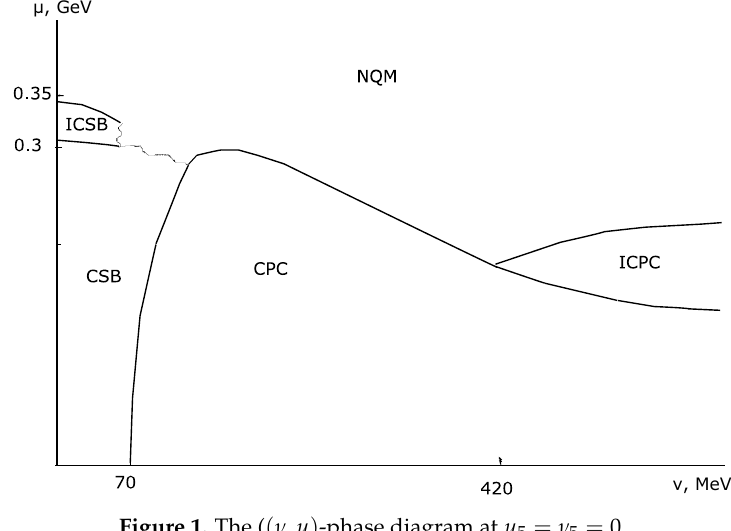
Figure 1. The ( ( ν , µ ) -phase diagram at µ 5 = ν 5 =